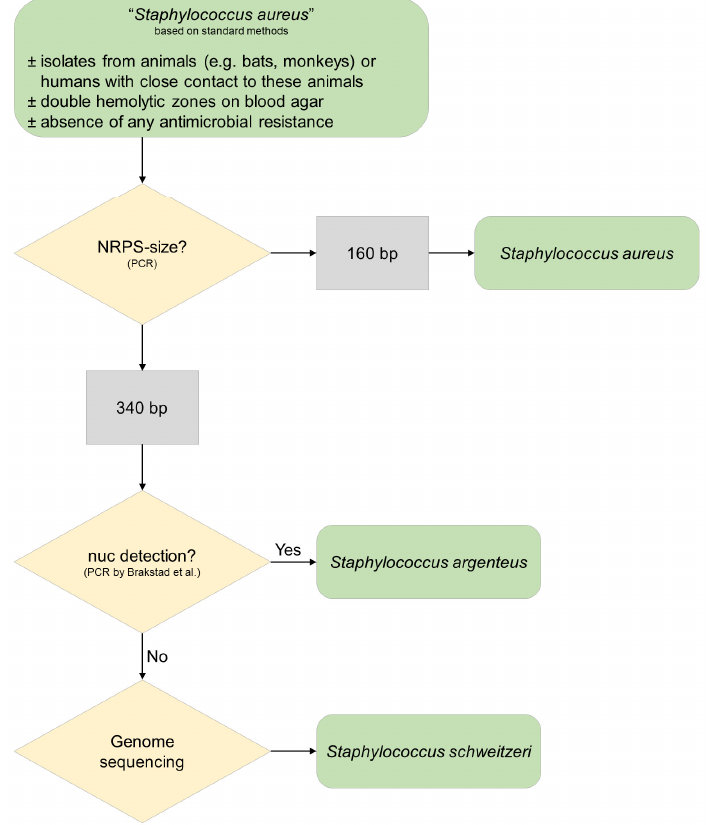
Figure 4. A proposed algorithm for the species identification of Staphylococcus schweitzeri . Colonies provisionally identified as “ Staphylococcus aureus ” should be further analyzed if they are from African wildlife and if the colonies have double hemolytic zones and do not show antimicrobial resistance. A two-step PCR approach (NRSP-PCR, nuc -PCR) should be followed by genome sequencing for ultimate species confirmation. There are hints that S. roterodami and S. singaporensis might be negative in the nuc -PCR by Brakstad et al. [37] .